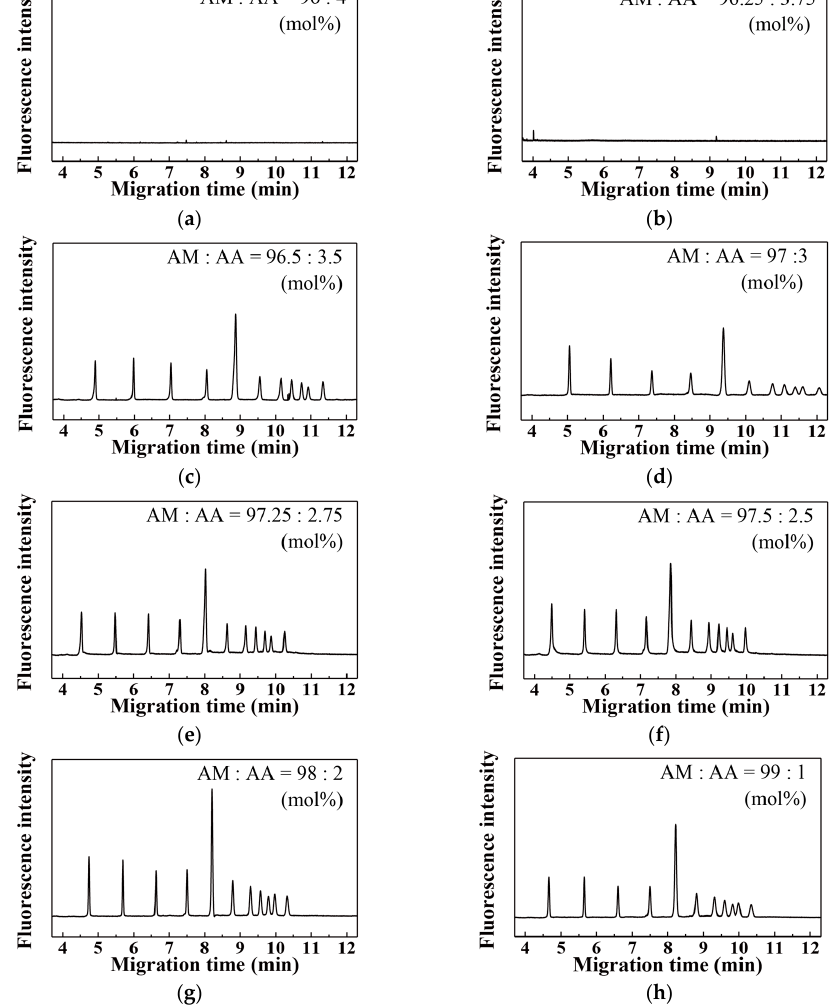
Figure 5. DNA separation by CGE for poly(AM- co -AA) coating with various AA contents: ( a ) 4 mol